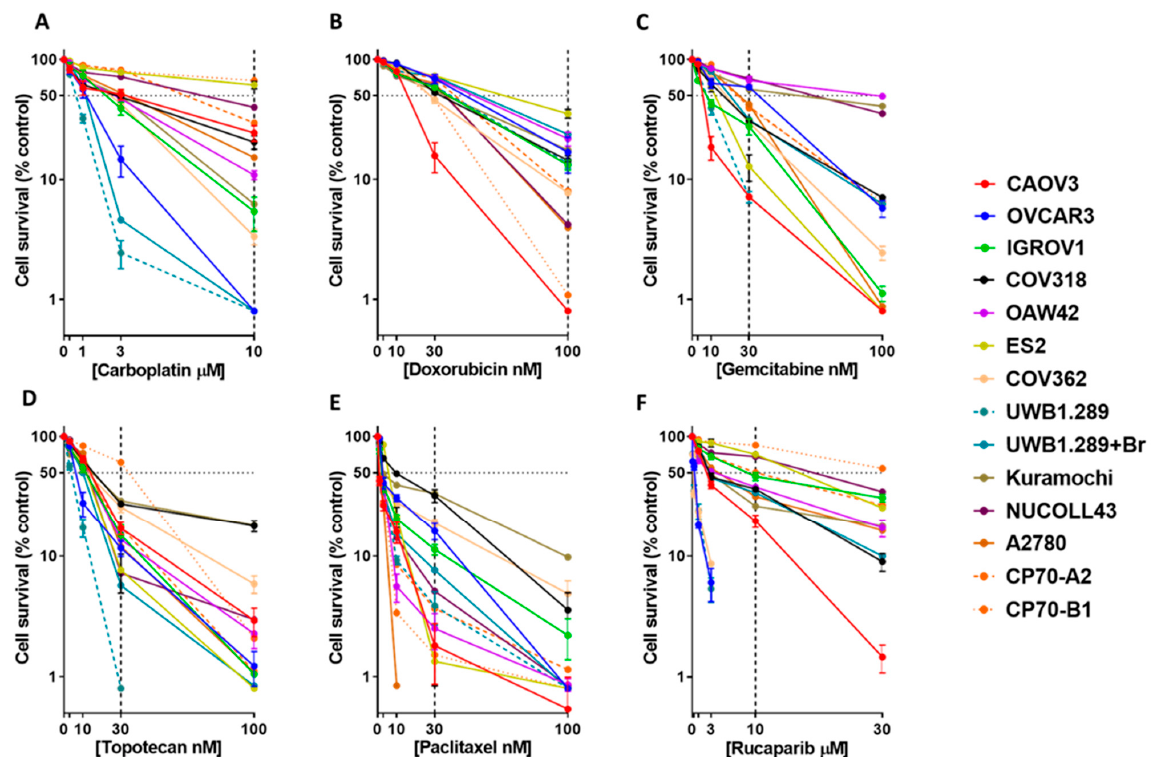
Figure 1. Cytotoxicity studies using a panel of 14 ovarian cancer cell lines identifies a spectrum of sensitivities for the six chemotherapeutic drugs. Colony formation assays to estimate the cytotoxic potential of ( A ) carboplatin (0–10 µ M), ( B ) doxorubicin (0–100 nM), ( C ) gemcitabine (0–100 nM), ( D ) topotecan (0–100 nM), ( E ) paclitaxel (0–100 nM), and ( F ) rucaparib (0–30 µ M). Each data point represents the mean and standard deviation of three biological replicates for each cell line.